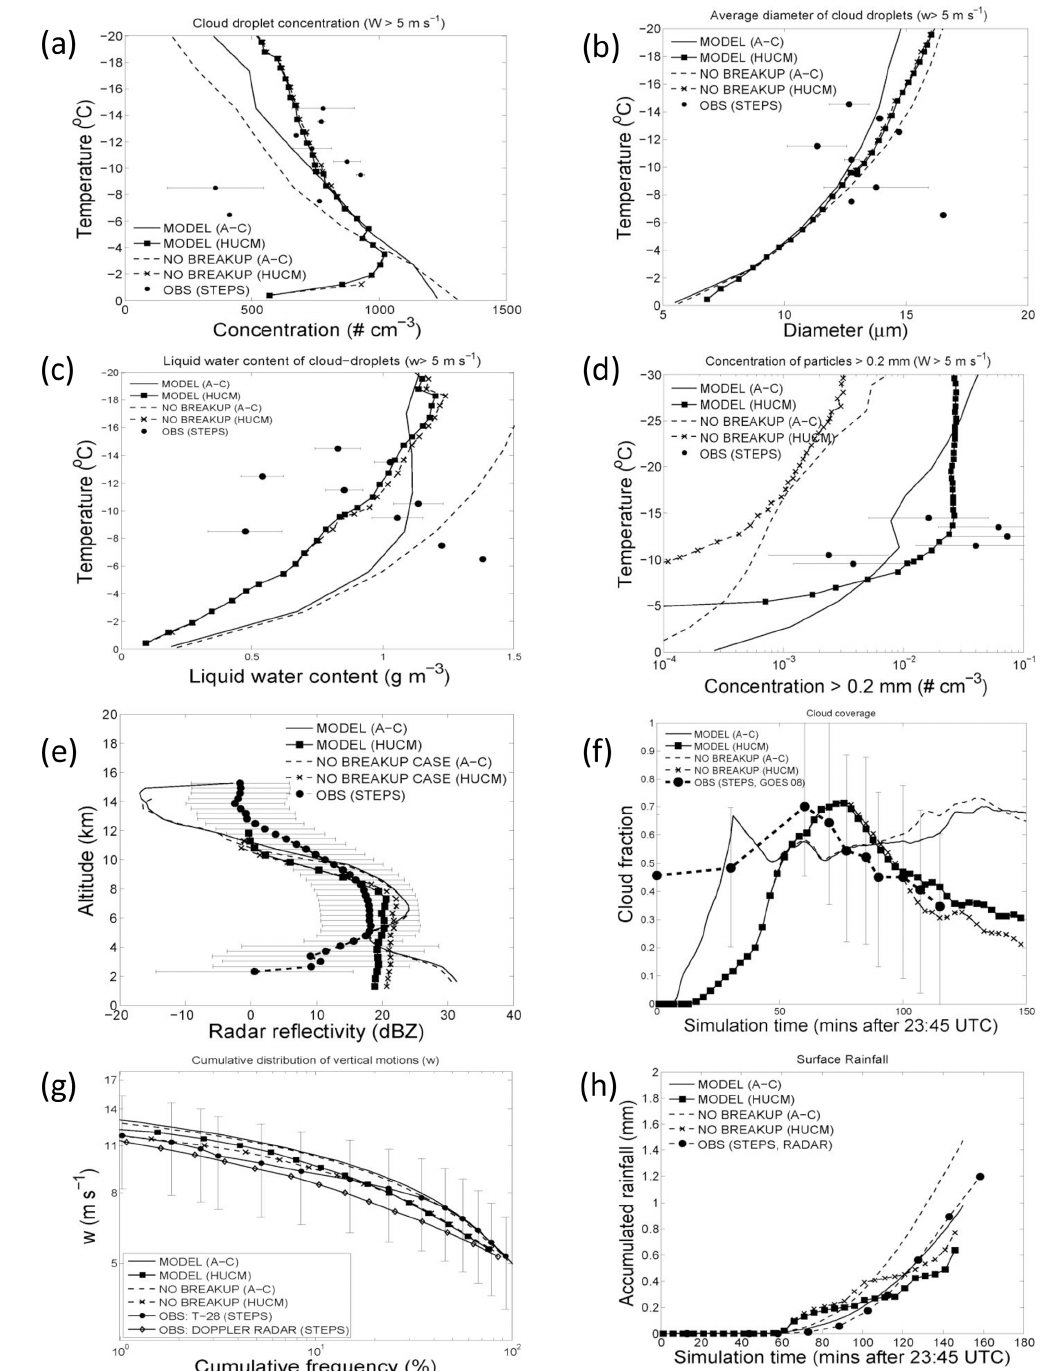
Figure 6. Validation of the aerosol–cloud (AC) simulation with and without the breakup in ice–ice collisions, using aircraft data, radar data and satellite data. Quantities shown are cloud droplet concentrations and mean size, liquid water content, ice concentration, radar reflectivity, cloud fraction, ascent statistics and surface-accumulated precipitation from (a) to (h) . Ice concentration is shown logarithmically in (d) , both with and without the breakup. Another simulation of the same case by the HUCM model is also shown. Source: Phillips et al. (2017b). © American Meteorological Society. Used with